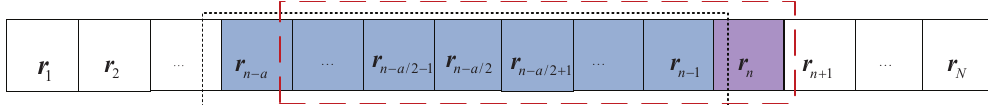
Figure 2. Casual sliding array window at r n with width specified by a